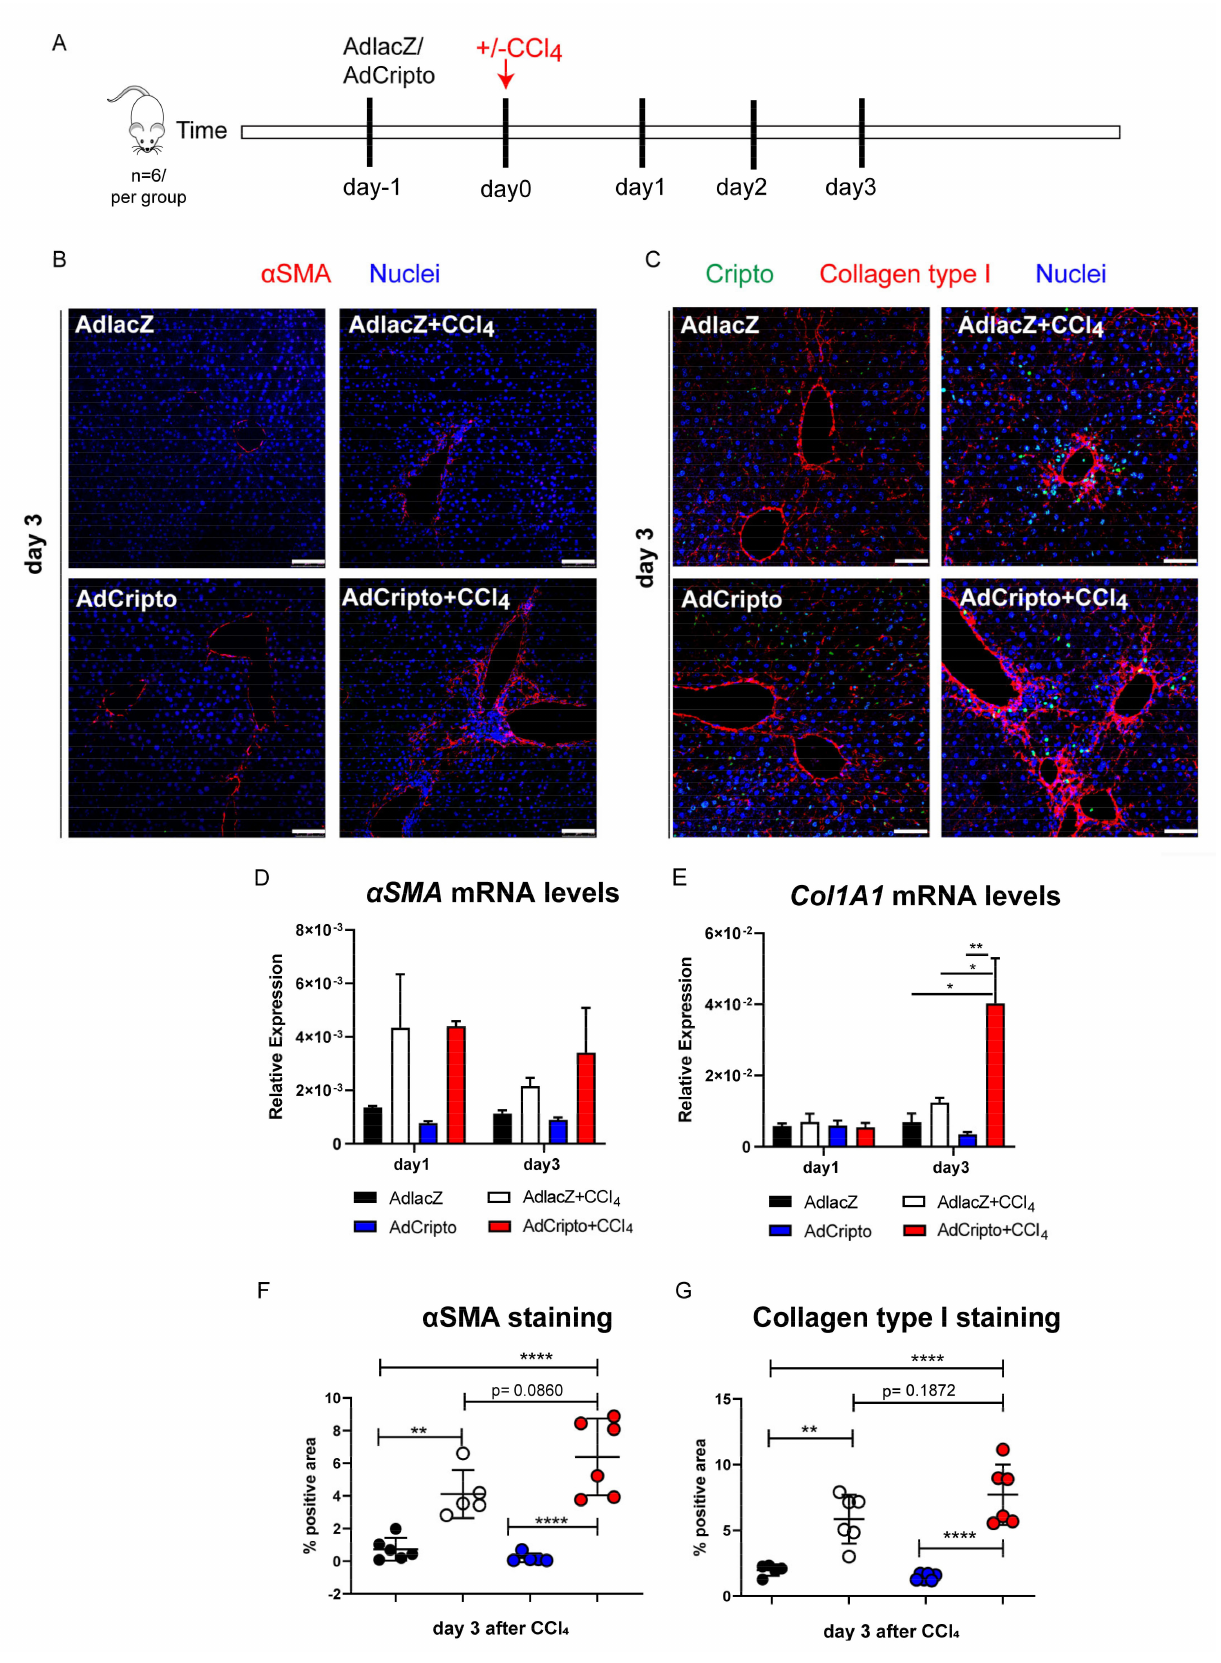
Figure 4. In vivo overexpression of Cripto in combination with CCl 4 exacerbates fibrosis. ( A ) Experimental setup.